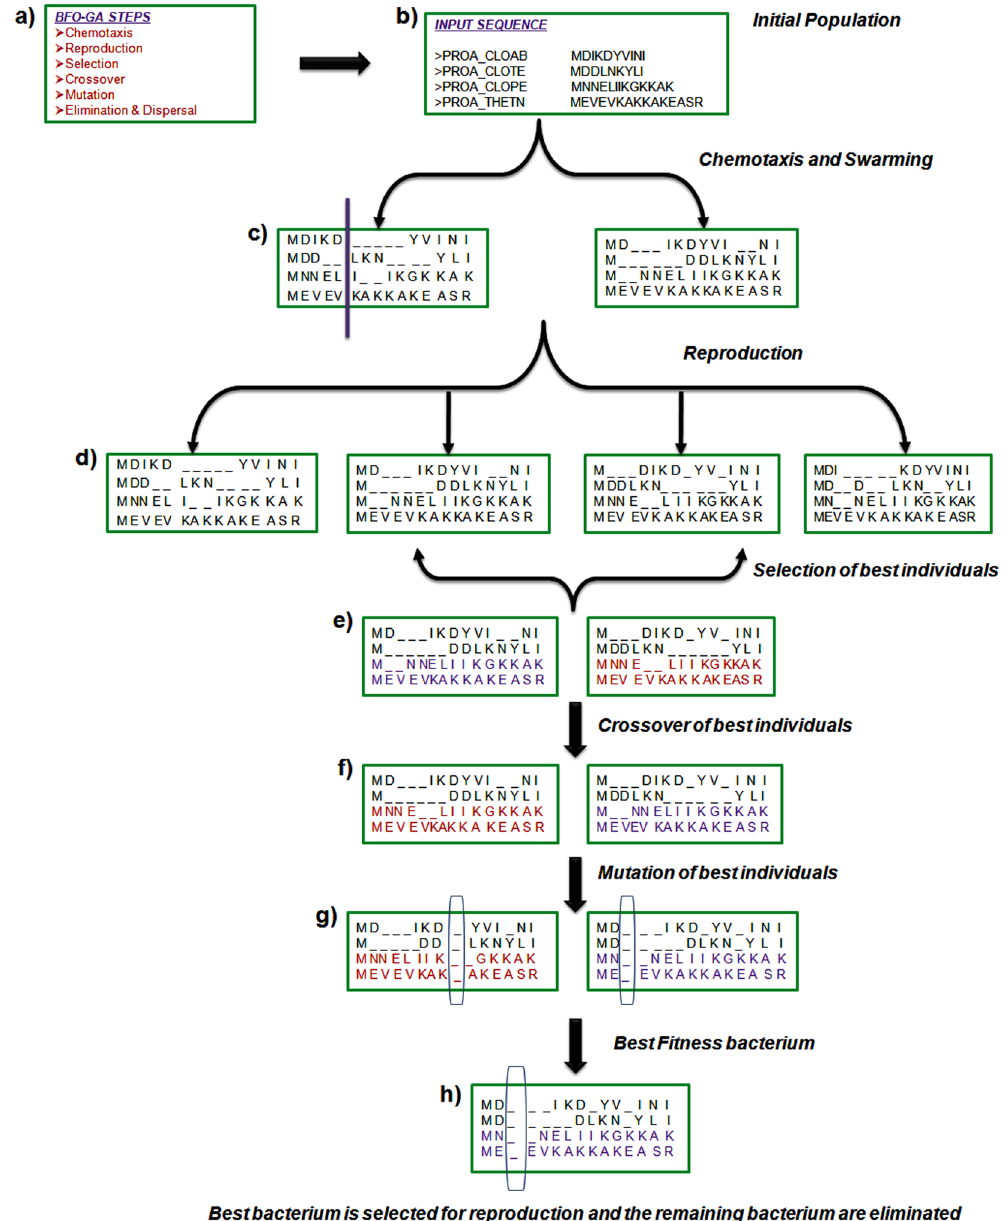
Figure 2. Flowchart of the proposed BFO-GA